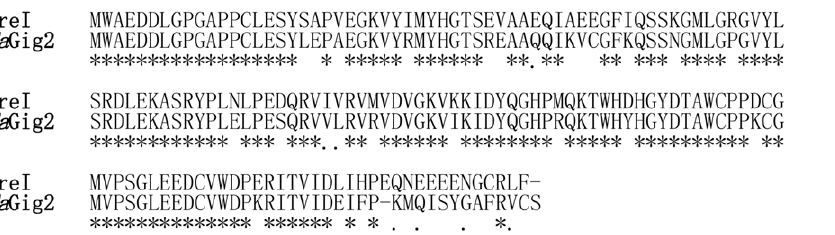
Figure 1. Alignment of amino acid sequences of DreI and Ca Gig2. The amino acid sequences of DreI and Ca Gig2 are deduced from the cDNA sequences (Accession numbers: DreI , HQ269376; CaGig2 , No. GQ181131). The identical (*) and similar (.) amino acids identified by Clustal X program are indicated.